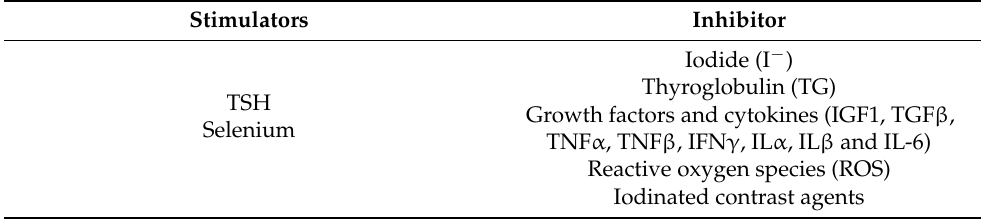
Table 2. Iodide uptake and the main regulators of thyroid hormone